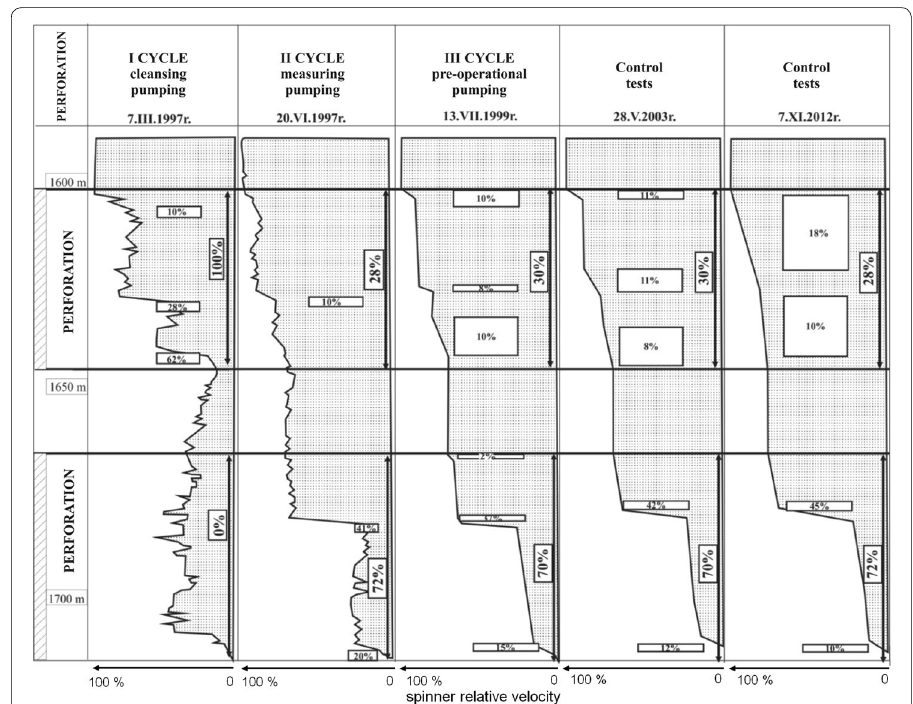
Fig. 8 Summary of production logging results from 1997, 1999, 2003 and 2012 (Bujakowski et al.